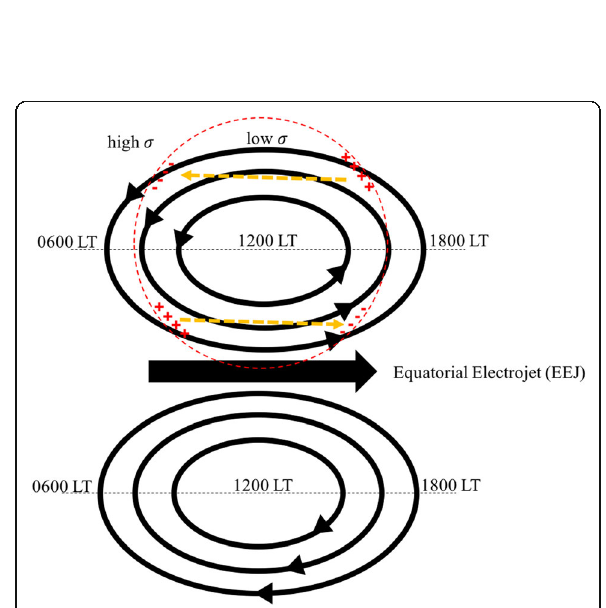
* (cid:2) B * ) in the eastward